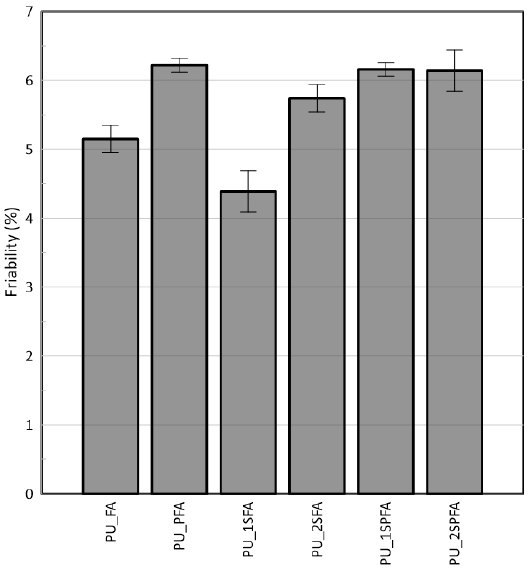
Figure 6. Dependence of the brittleness of polyurethane composites on the type of filler used.